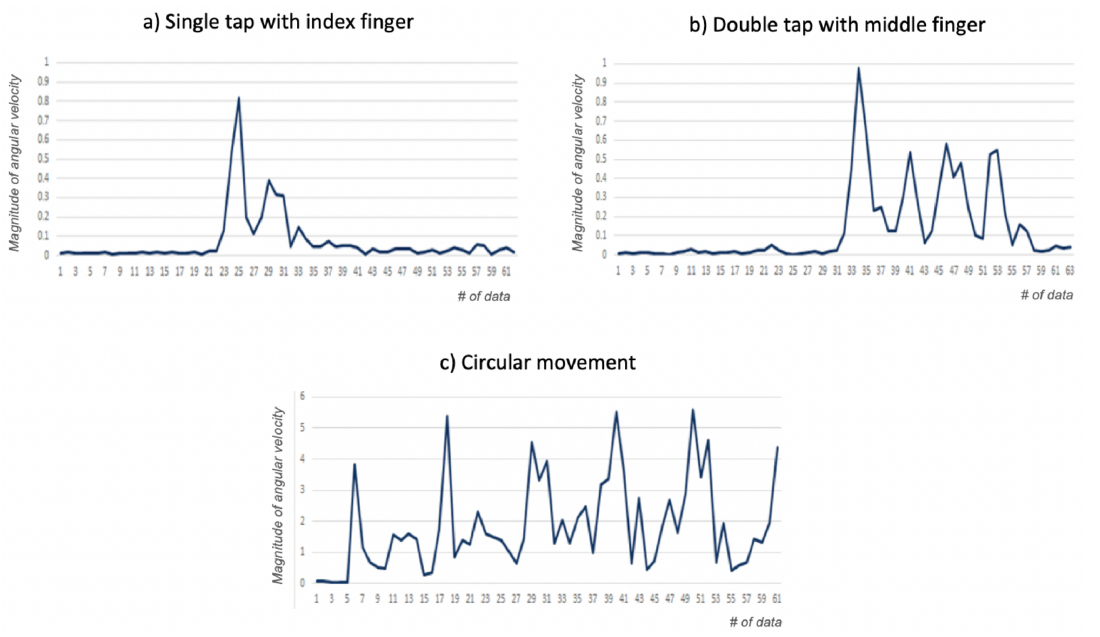
Figure 4. Recognizing the presence of a gesture using DTW. ( a ) Signal of the magnitude of angular velocity used as a reference (single-tap with index finger). ( b ) Signal in which the presence of a gesture is correctly inferred (double-tap with ring finger). ( c ) Signal from a hand performing another movement (circular movement with the